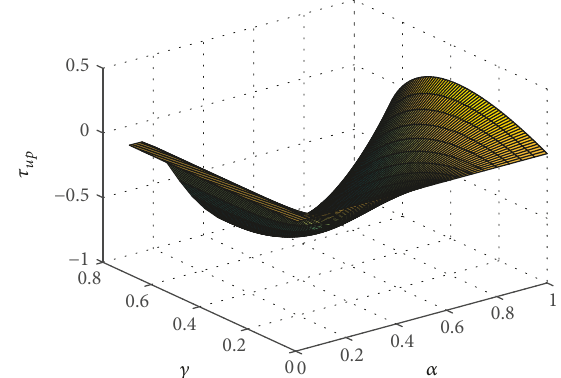
up with respect to